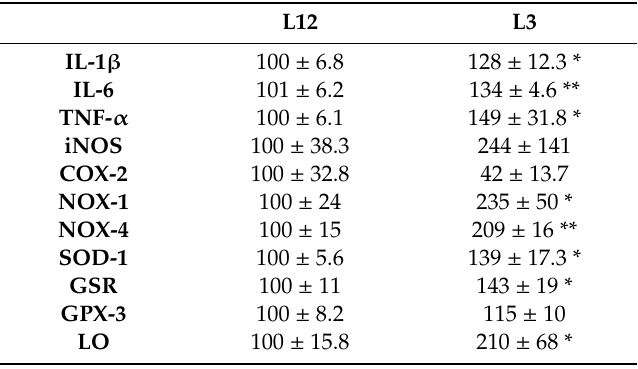
Table 3. Gene expression of interleukin 1-beta (IL-1 β ), interleukin- 6 (IL-6), tumor necrosis